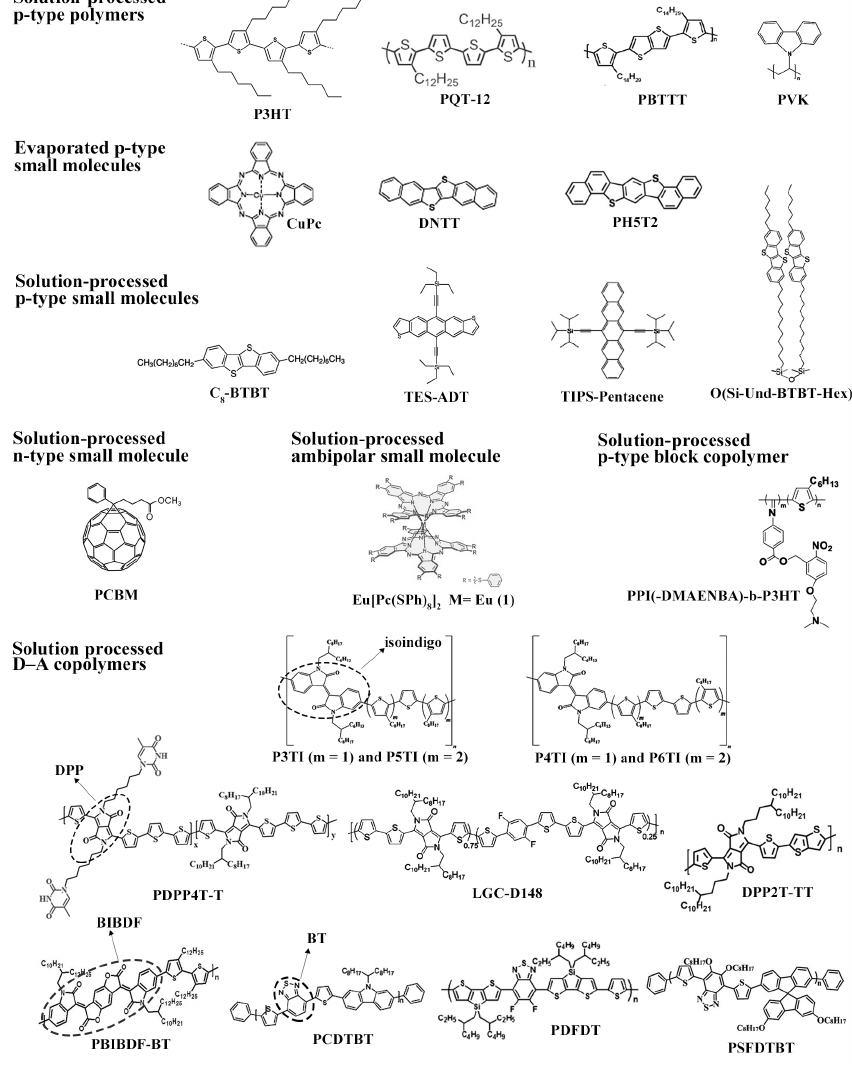
Figure 7. Chemical structures of organic semiconducting molecules for organic thin-film transistors in gas sensing